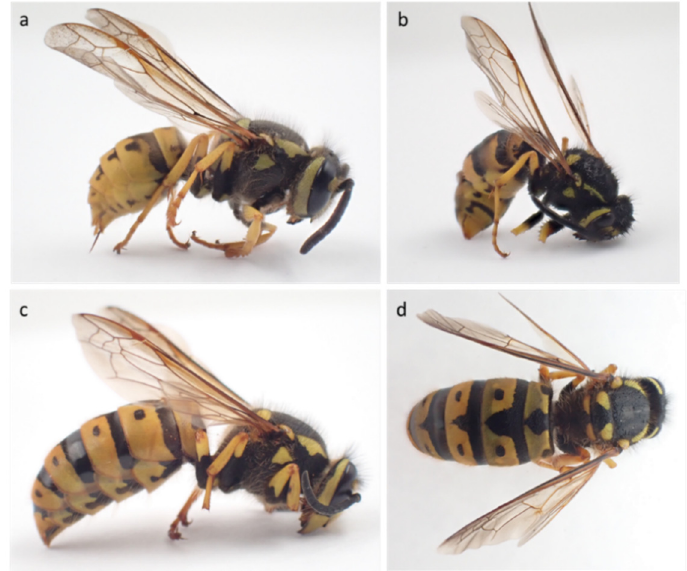
Figure 1. Representative specimens of Vespula germanica collected in South Africa: ( a ) Worker specimen 40 A, ( b ) Worker specimen 140 A, ( c ) Queen specimen 127 A lateral, and ( d ) dorsal view.